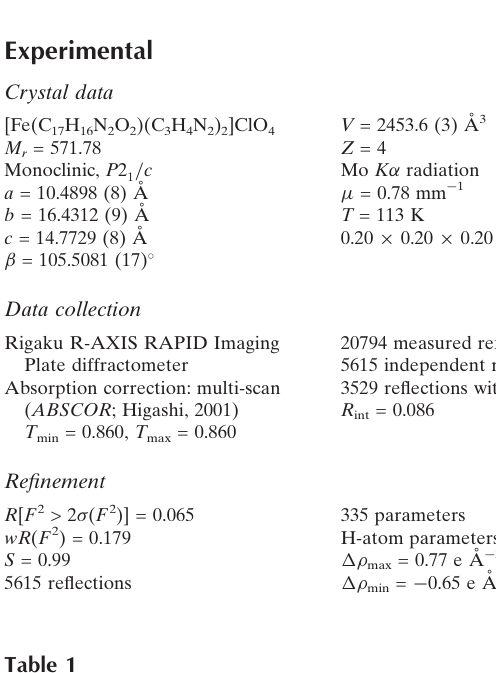
Selected bond lengths (A˚ ).